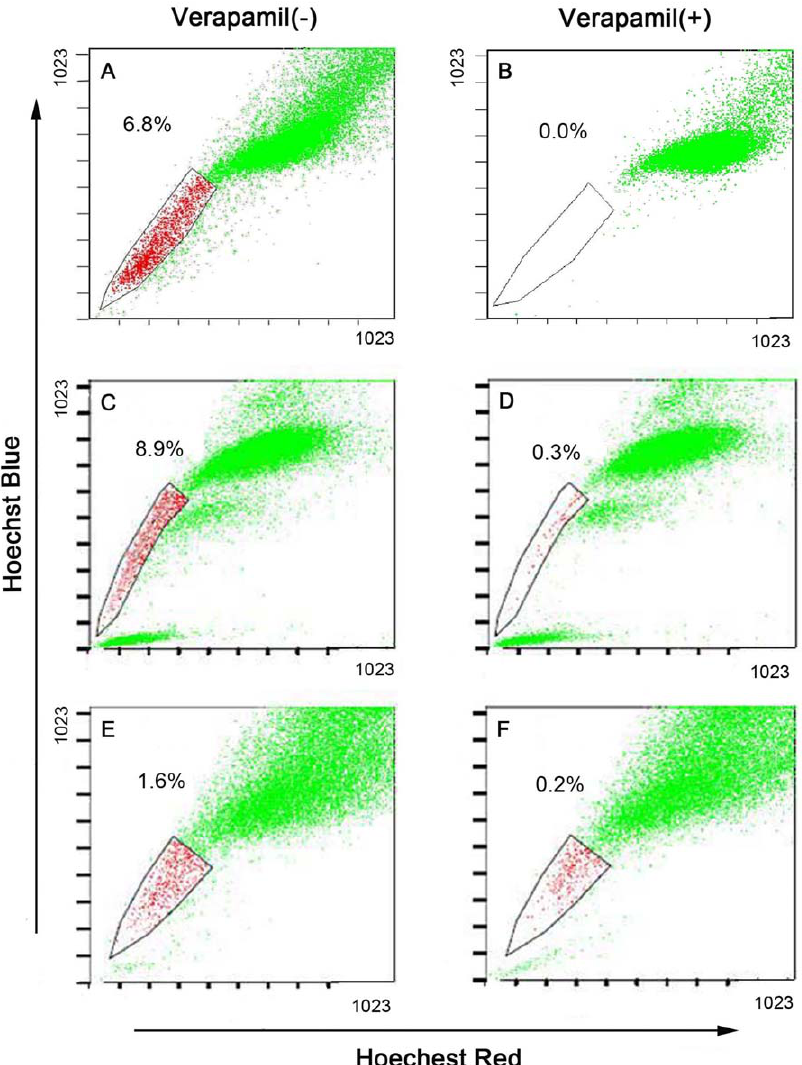
Figure 3. SP re-analysis in various samples. A–B, SP re-analysis when the SP spheres were disaggregated and dissociated cells cultured in normal serum-containing medium for one week. C–D, SP re-analysis in the SP cell-derived tumors. E–F, SP re-analysis in non-SP cell-derived tumors. A, C, E, without verapamil. B, D, F, with verapamil.